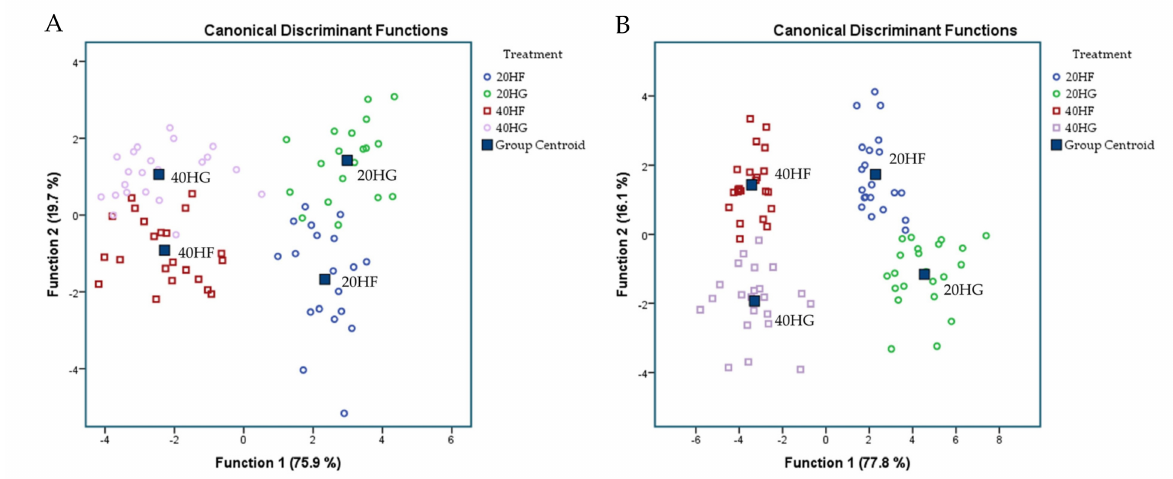
Figure 3. Discriminant plots separating ( A ) the four dietary treatments (20 HF; blue, 20 HG; green, 40 HF; red, and 40 HG; pink) according to pooled data of two sampling time (21st and 42nd experimental day) on the blood plasma fatty acid profile and ( B ) the four dietary treatments (20 HF; blue, 20 HG; green, 40 HF; red, and 40 HG; pink) according to pooled data of two sampling time (21st and 42nd experimental day) on the milk fatty acid profile. 20 HF: 20 g Schizochytrium spp. and high forage diet (60:40); 20 HG: 20 g Schizochytrium spp. and high grain diet (40:60); 40 HF: 40 g Schizochytrium spp. and high forage diet (60:40); 40 HG: 40 g Schizochytrium spp. and high grain diet